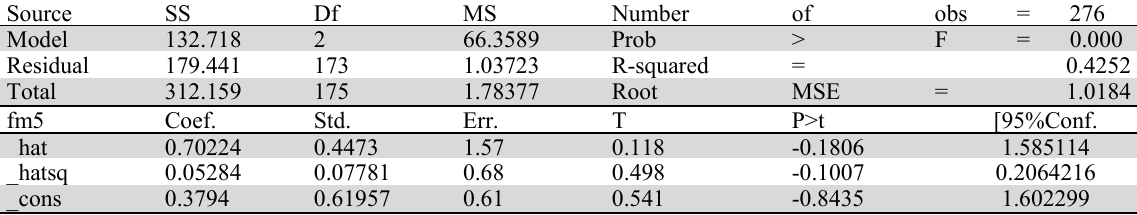
Proper policies for safeguarding physical and financial assets in the business (FM5)